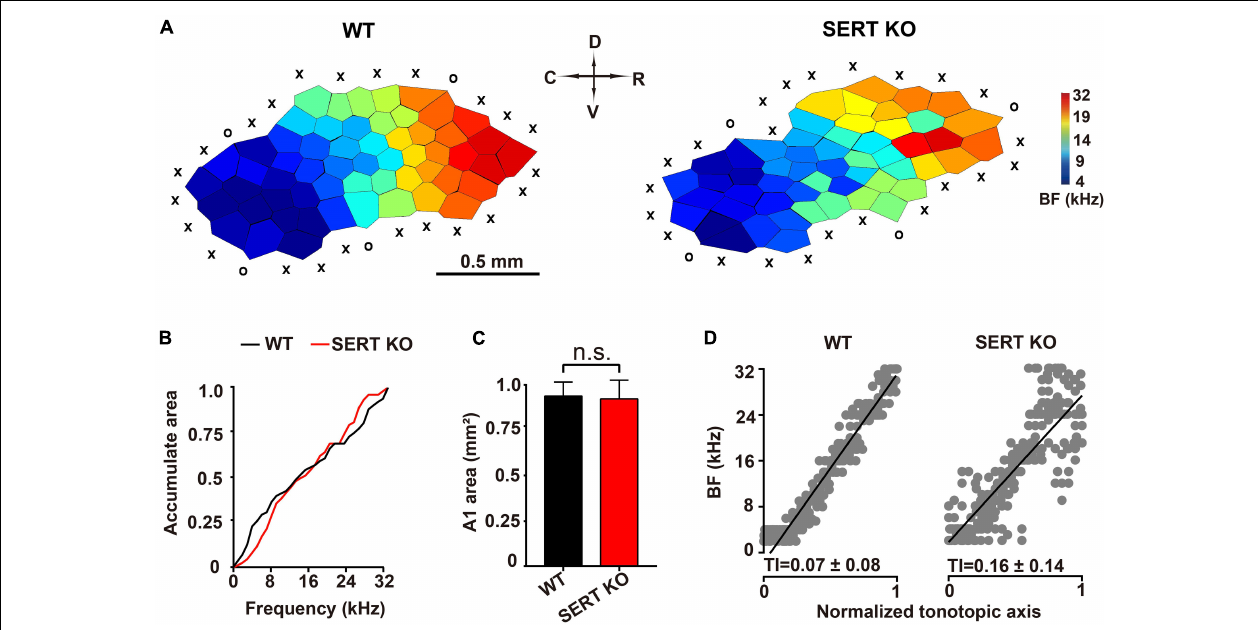
FIGURE 4 | Disturbed tonotopic organization of primary auditory cortex in serotonin transporter (SERT) knockout (KO) mice. (A) Representative A1 characteristic-frequency map from a wild-type (WT) mouse (left) and a SERT KO mouse (right). Scale bar: 0.5 mm. X, unresponsive cortical site; O, non-A1 cortical site (see section “Materials and Methods”). (B) Plotting accumulated response areas at best frequency for neurons of primary auditory cortex in WT and SERT KO mice. (C) The total areas of primary auditory cortex in WT mice and SERT KO mice. (D) The best frequencies of all recorded sites in WT and SERT KO mice were plotted against a normalized tonotopic axis. The tonotopic index (TI) represents the increased scatter of best frequencies around the ideal tonotopic axis (black diagonal line) (see section “Materials and Methods”). Data are presented as means ± SD. ns, no statistical difference, p > 0.05. Student’s t -test.